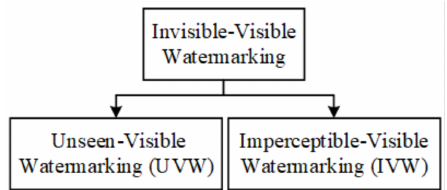
Figure 1. Invisible–visible watermarking